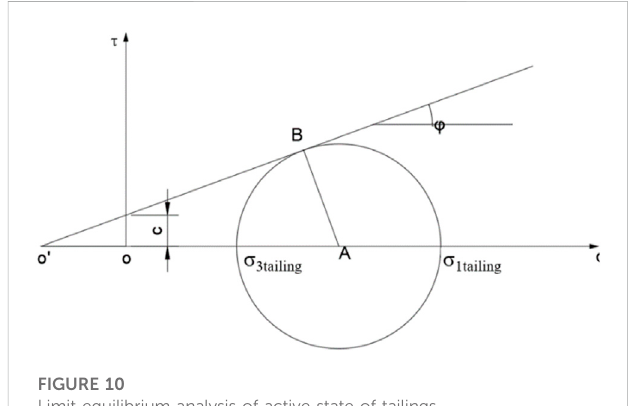
FIGURE 10 Limit equilibrium analysis of active state of